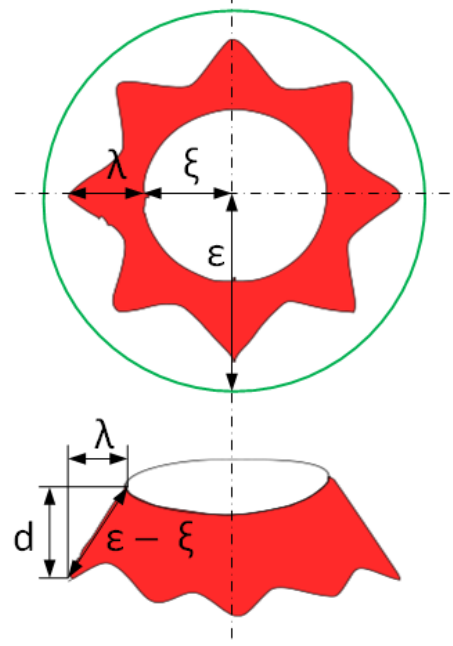
Figure 4. Determining the 3D shape of the drape.